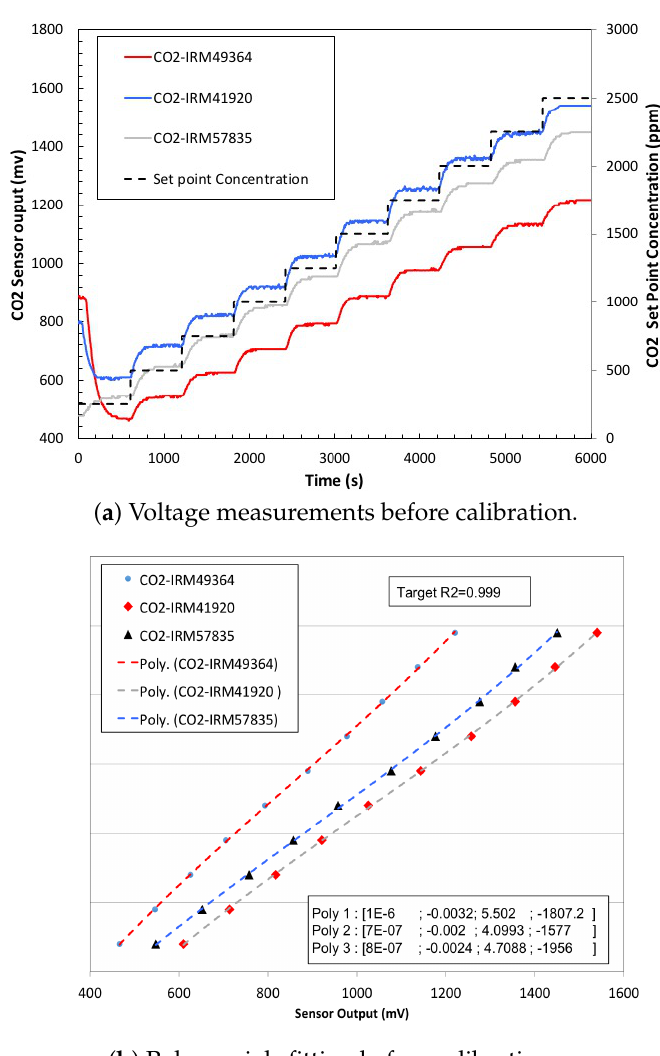
( b ) Polynomials fitting before calibration. Figure 15. CO 2 sensor response to stepping of CO 2 concentration before calibration, ( CO2-IRM49364 , R 2 = 0.999922) ( CO2-IRM41920 , R 2 = 0.997149) ( CO2-IRM57835 , R 2 = 0.993695).